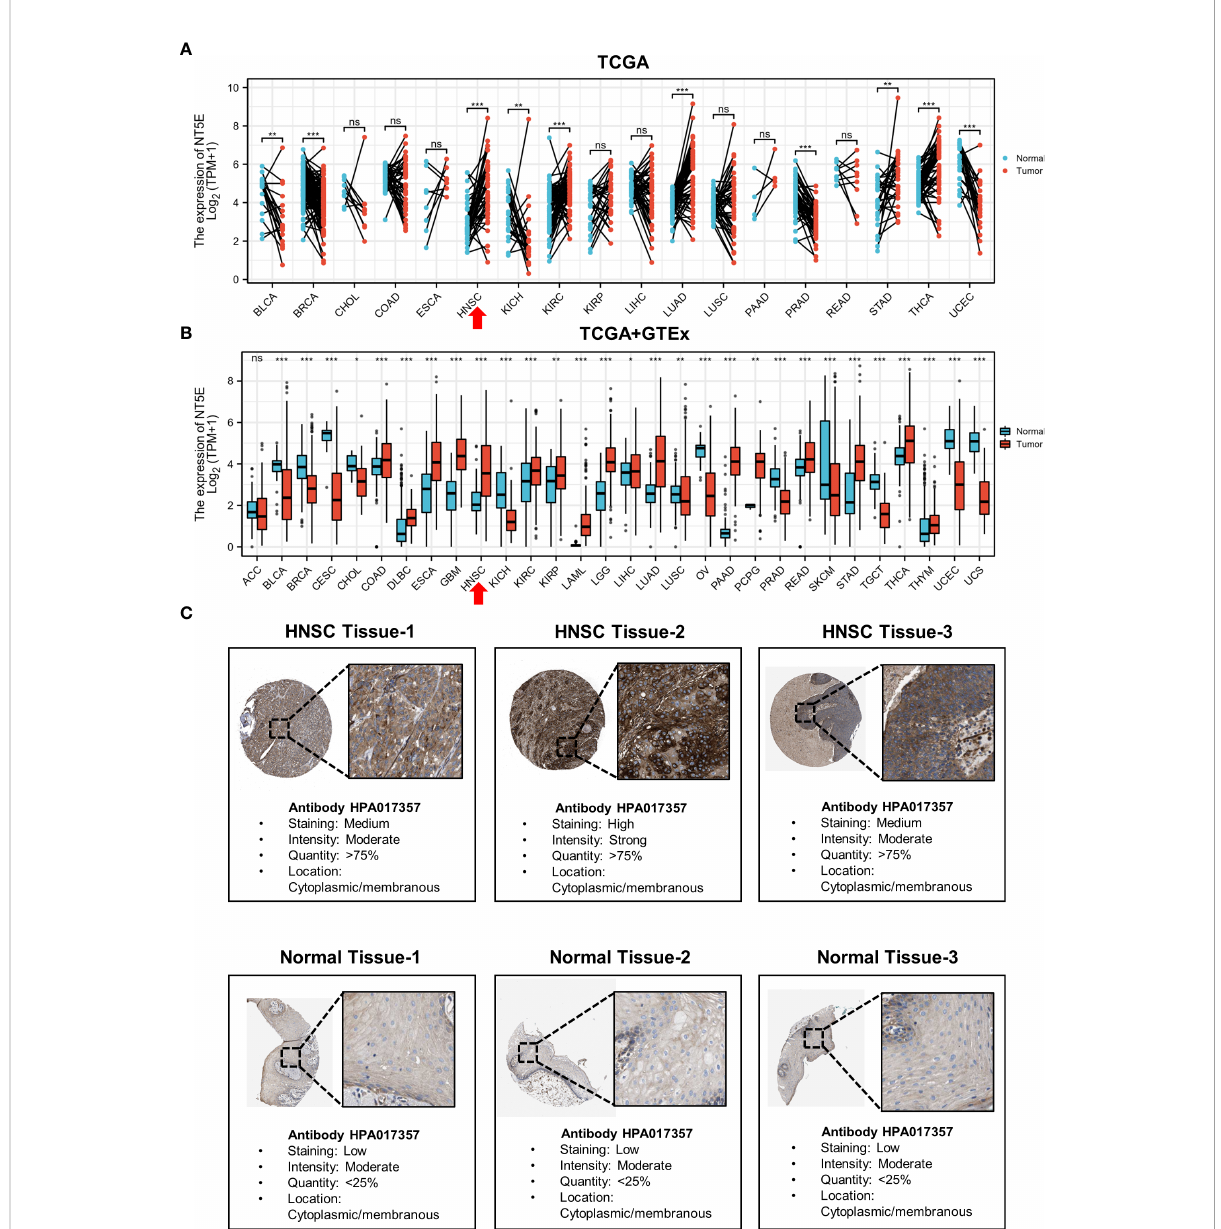
FIGURE 1 The upregulated expression of NT5E in HNSC. (A) The expression distribution of NT5E in tumor and paired-normal tissues (TCGA database). (B) The expression distribution of NT5E in tumor and normal tissues (TCGA and GTEx database). (C) The expression of NT5E protein in HNSC and normal tissues (HPA database). (ns, p ≥ 0.05, * p < 0.05, ** p < 0.01, *** p <